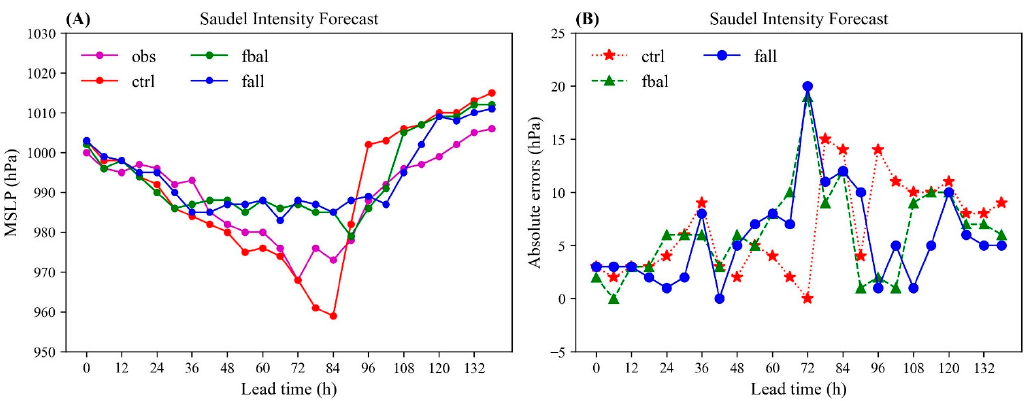
Figure 7. Similar to Figure 6 but for intensity forecast, ( A ) is the forecast results of different time periods, and ( B ) is the corresponding errors. The intensity of Saudel is identified by the minimum mean sea level pressure (MSLP), and the absolute error is equal to the absolute value of the differ ‐ ence between the forecast and the observation.